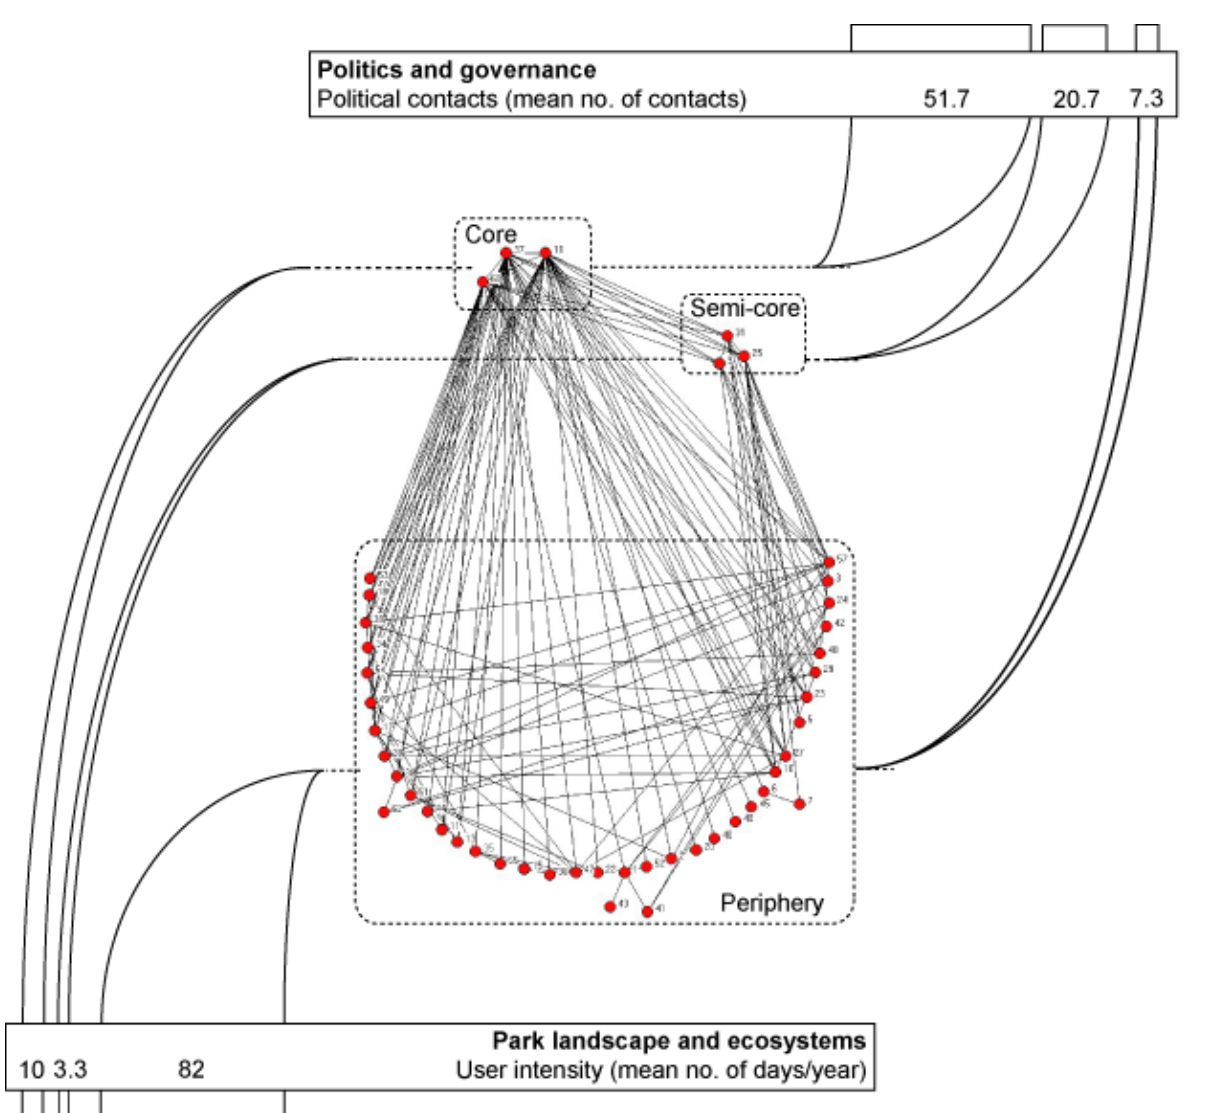
Fig. 5. Through their struggle to protect the National Urban Park, the Ecopark movement has come to link the politics of the park with its ecosystems. Core and semi-core actors connect to decision makers through many political contacts, whereas peripheral actors have higher user intensity and more day-to- day activity in the park. The values are taken from Table 2, with the WWF removed, as discussed in the main